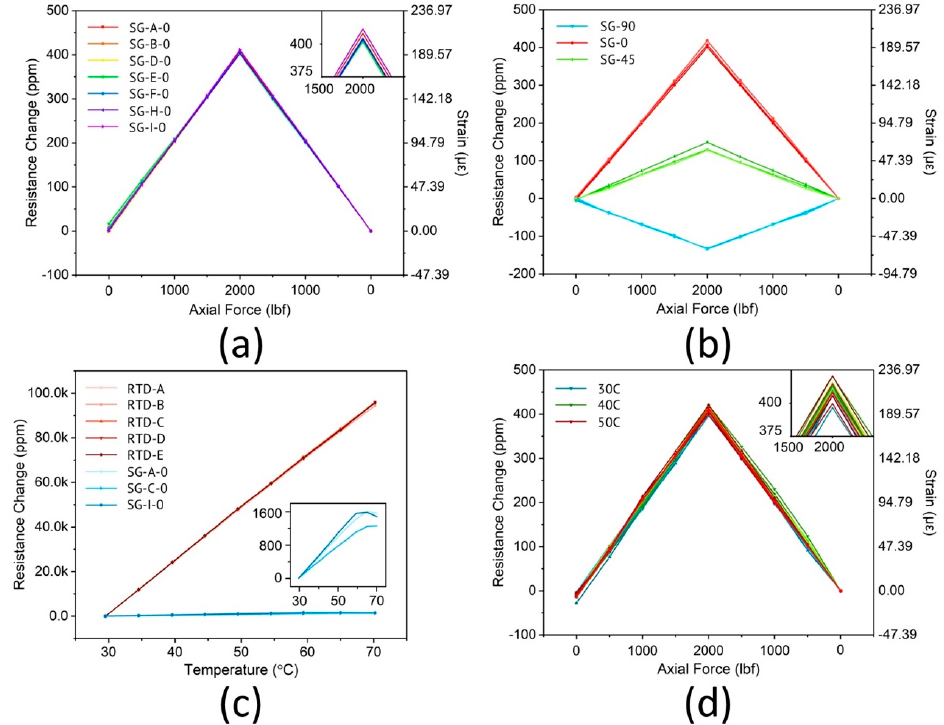
Figure 9. Relative resistance change of the strain gauges in response to load change and the